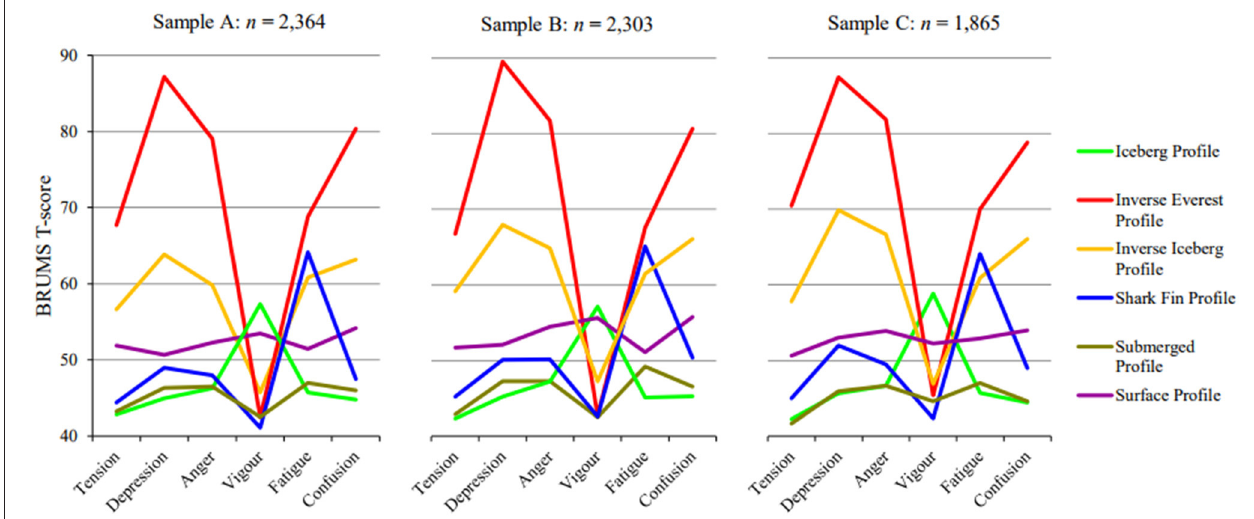
FIGURE 1 | Visual summary of the 6-cluster solutions in three